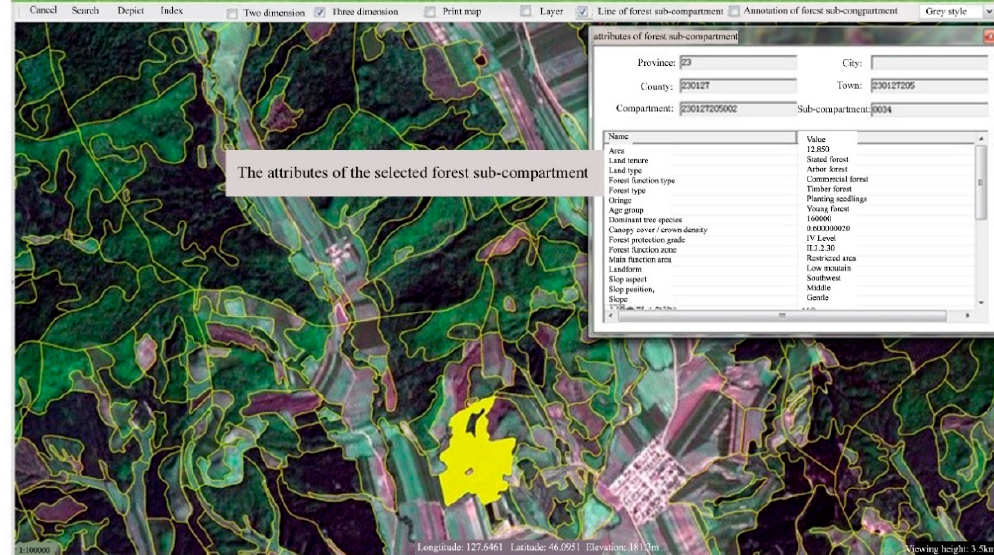
Figure 2. The interface of the Forest Management Planning Inventory (FMPI) digital data system (Dotted lines refer to the boundary of forest sub-compartments).